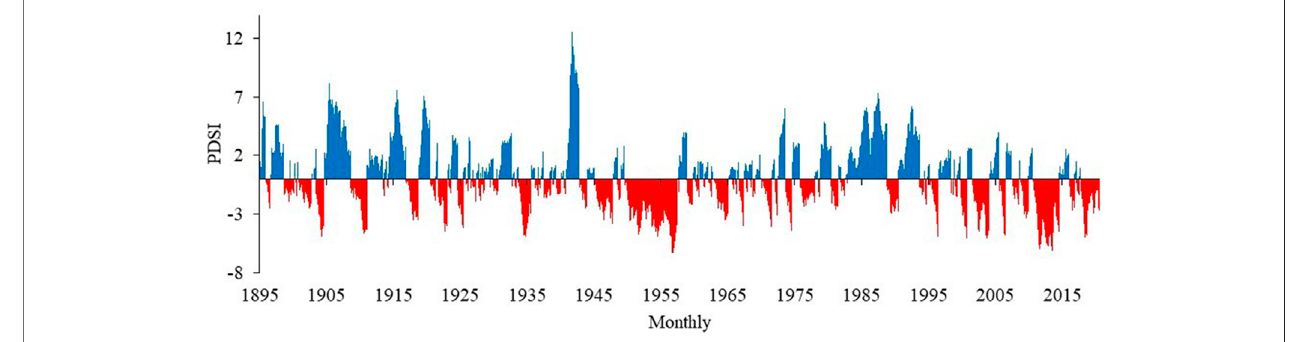
FIGURE 8 | Palmer Drought Severity Index (PDSI) for New Mexico (1895 –